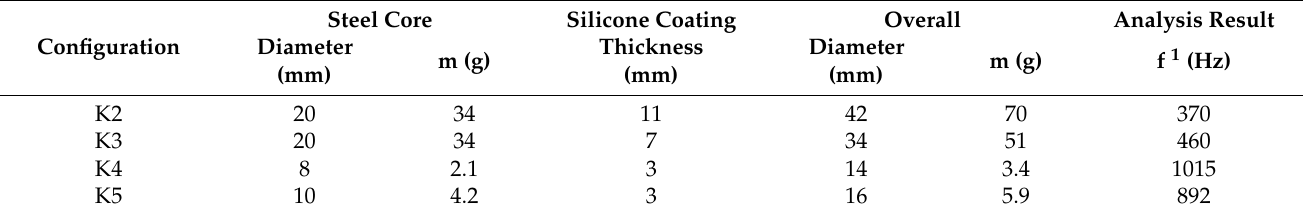
Table 2. The core-coating sizes used in this